Question: What visual encoding does this figure use to show its data?
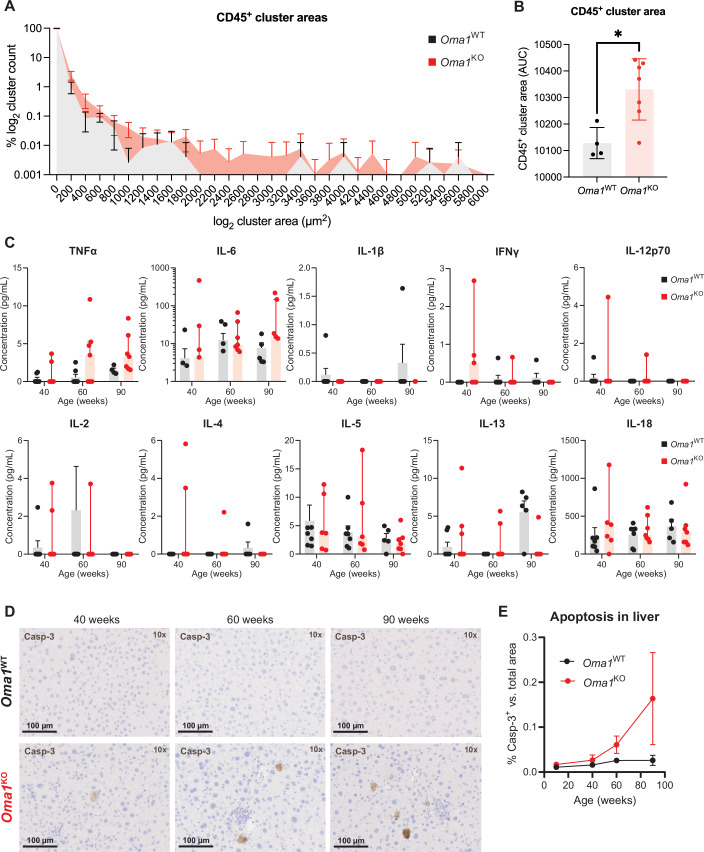
Answer: histogram